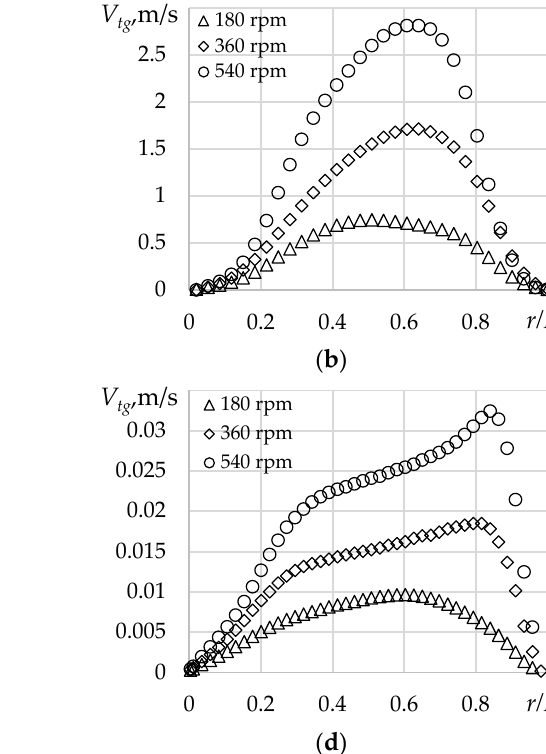
Figure 7. Tangential velocity profiles in air ( a ) at h = 0.5, ( b ) at h = 0.8, and in glycerin ( c ) at h = 0.5 and ( d ) at h = 0.8.